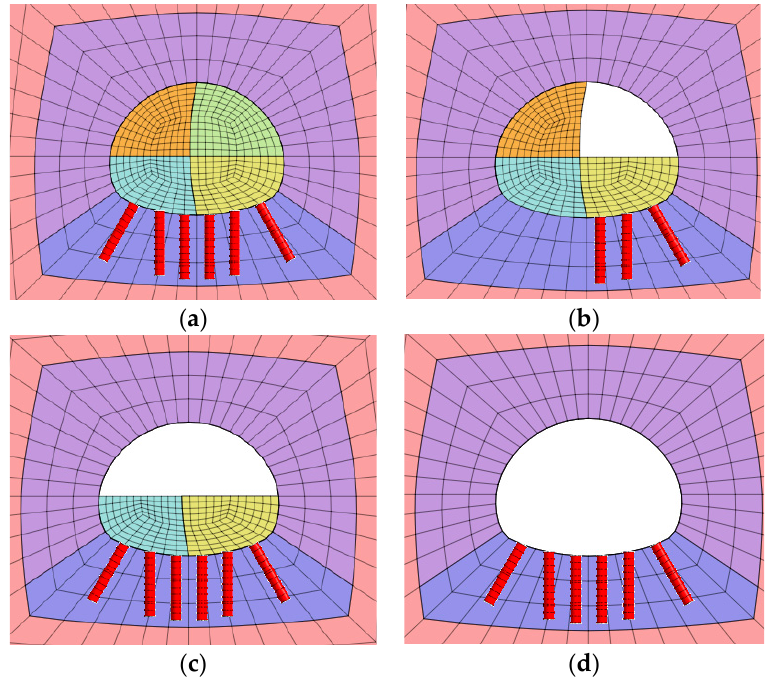
Figure 5. The opportunity of jet grouting pile reinforcement: ( a ) Embedded type; ( b ) Twice application; ( c ) Once application; ( d ) Layout after excavation.